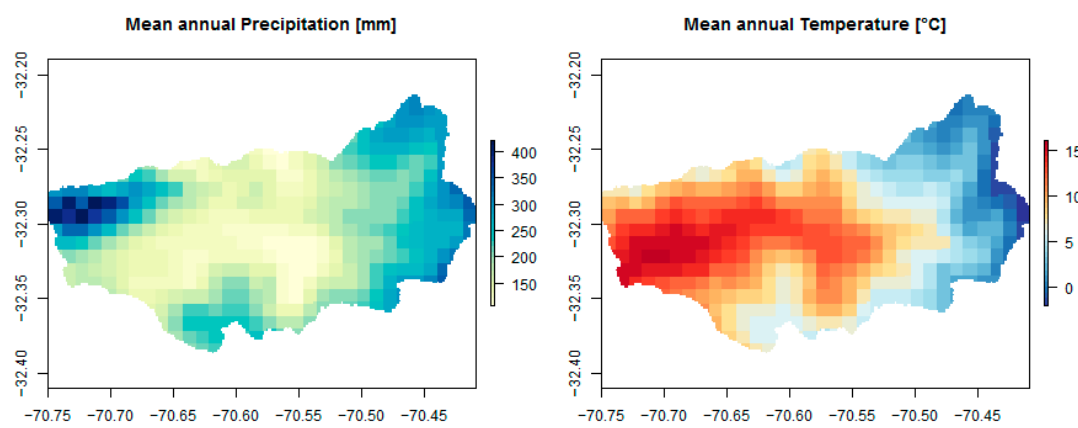
Figure 3. Maps covering the Alicahue River Basin for: ( left ) Mean annual precipitation, ( right ) mean temperature.